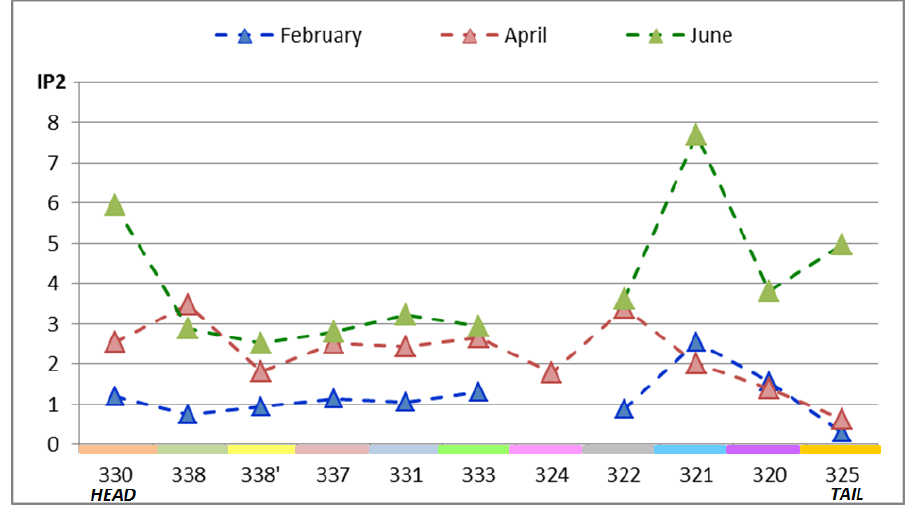
Figure 19. Head–tail end patterns of IP2 in the irrigated perimeter of